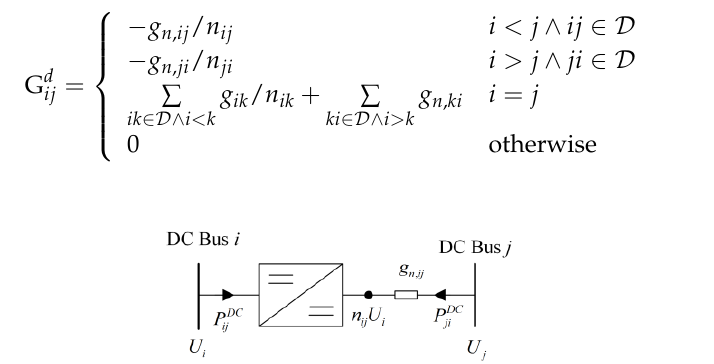
Figure 4. Transmission branch containing a DC/DC converter.